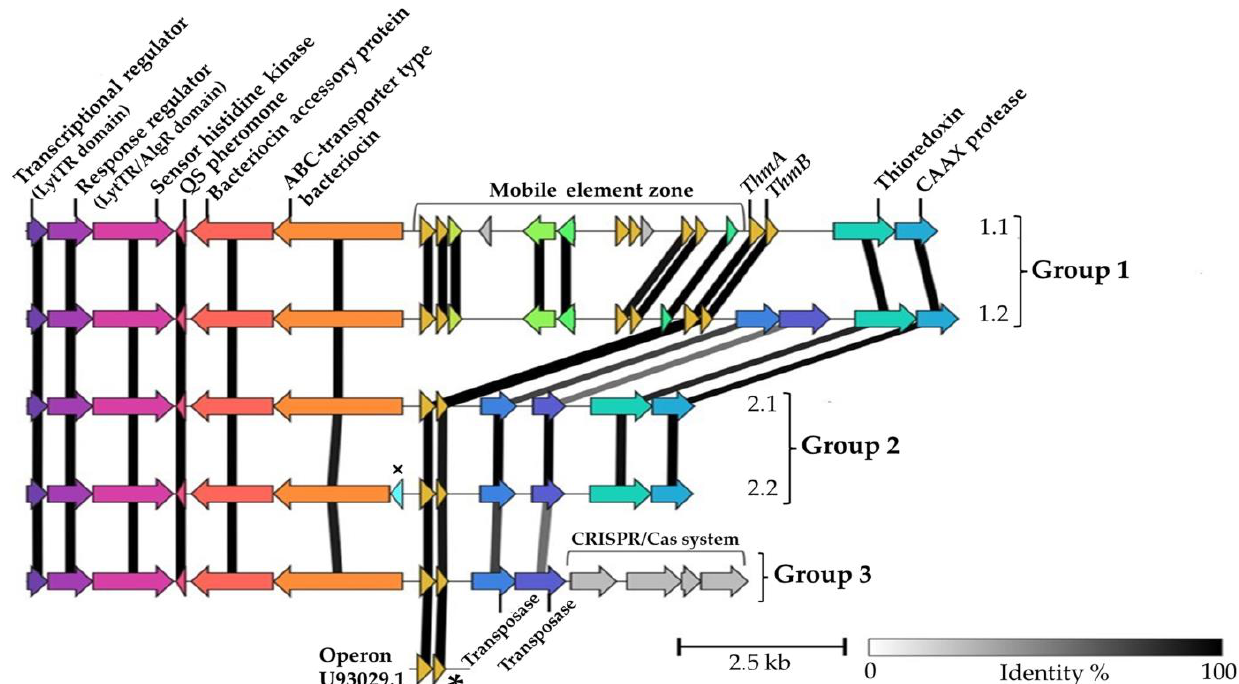
Figure 2. Comparison of the BGCs of thermophilin 13. Predicted ORFs are represented as arrows. Three main gene arrangements were detected. Subgroup 1.1 contains strain S. macedonicus 19AS and subgroup 1.2 strains S.thermophilus STH_CIRM_1049, S. thermophilus STH_CIRM_1048, S. thermophilus DMST-H2. Group 2 is divided into two subgroups, with strains S. thermophilus KLDS 3.1003, S. thermophilus TK-P3A, S. thermophilus CS9 in subgroup 2.1 and strains S. thermophilus LMD-9, S. thermophilus ATCC 19258 and S. thermophilus NCTC 12958 in subgroup 2.2. Group 3 is represented by strain S.thermophilus CS9. The symbol * indicates the third ORF (ORFC), encoded by the U93029.1 operon and symbol × indicate the C39 peptidase-like domains found only in subgroup 2.2. Colours are based on ORFs similarity found, including the mobile element zone, which were identified as small ORFs with apparent unrelated functions in the bacteriocins productions due to the prediction as hypothetical proteins.